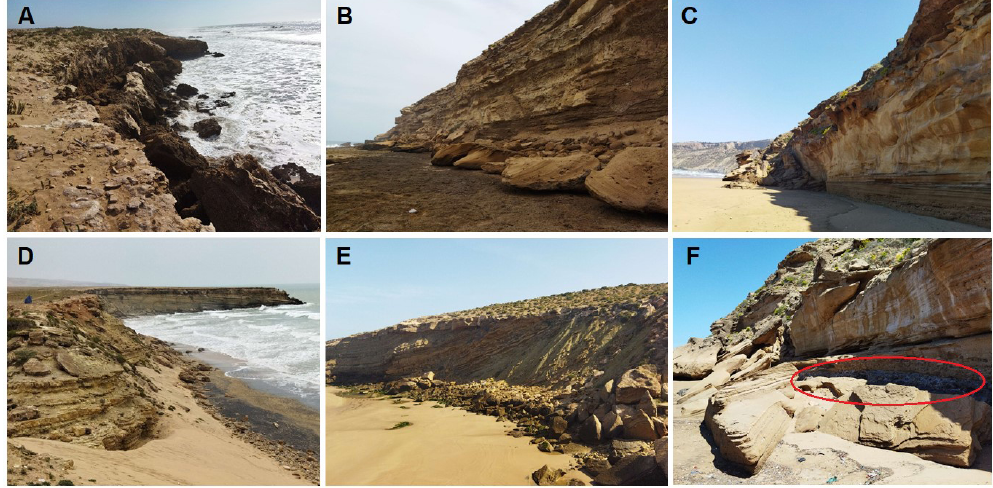
Figure 8. Examples of some conditioning factors: (A) absence of toe protection, (B) rock platform protection, (C) beach protection, (D, E) tilted layers towards sea, and (F) cliff toe lithology